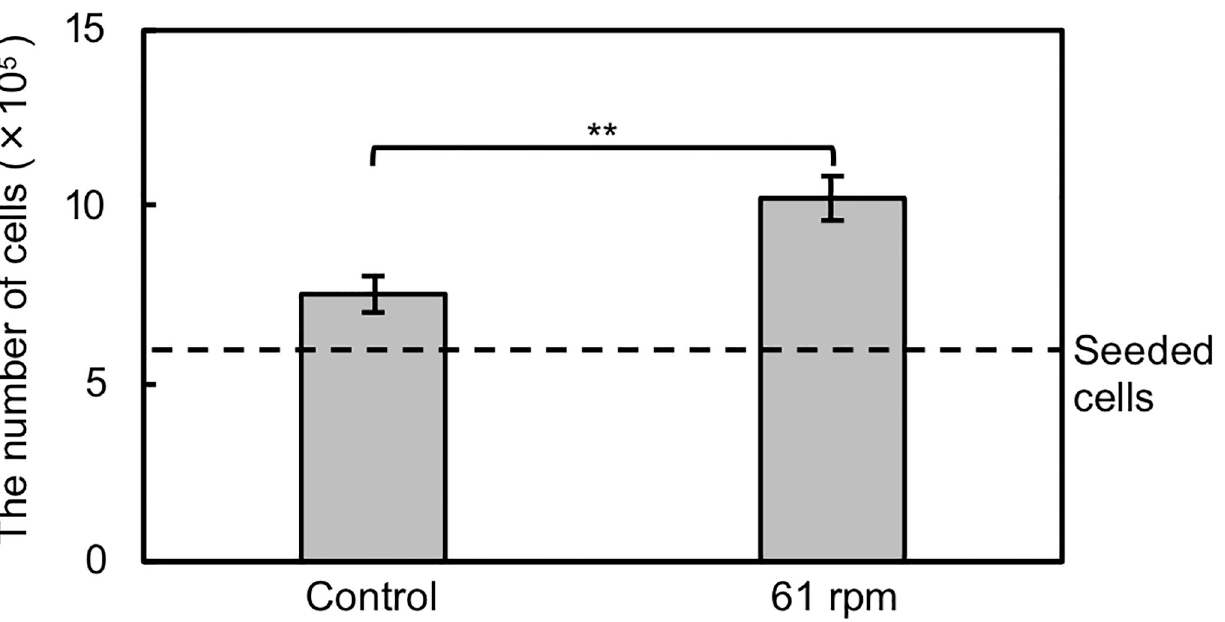
Fig 6. Numbers of cells after 24 h of culture. The initial cell density was homogenized by orbital shaking at 61 rpm. Data are shown as mean ± SD ( n = 4). �� p <